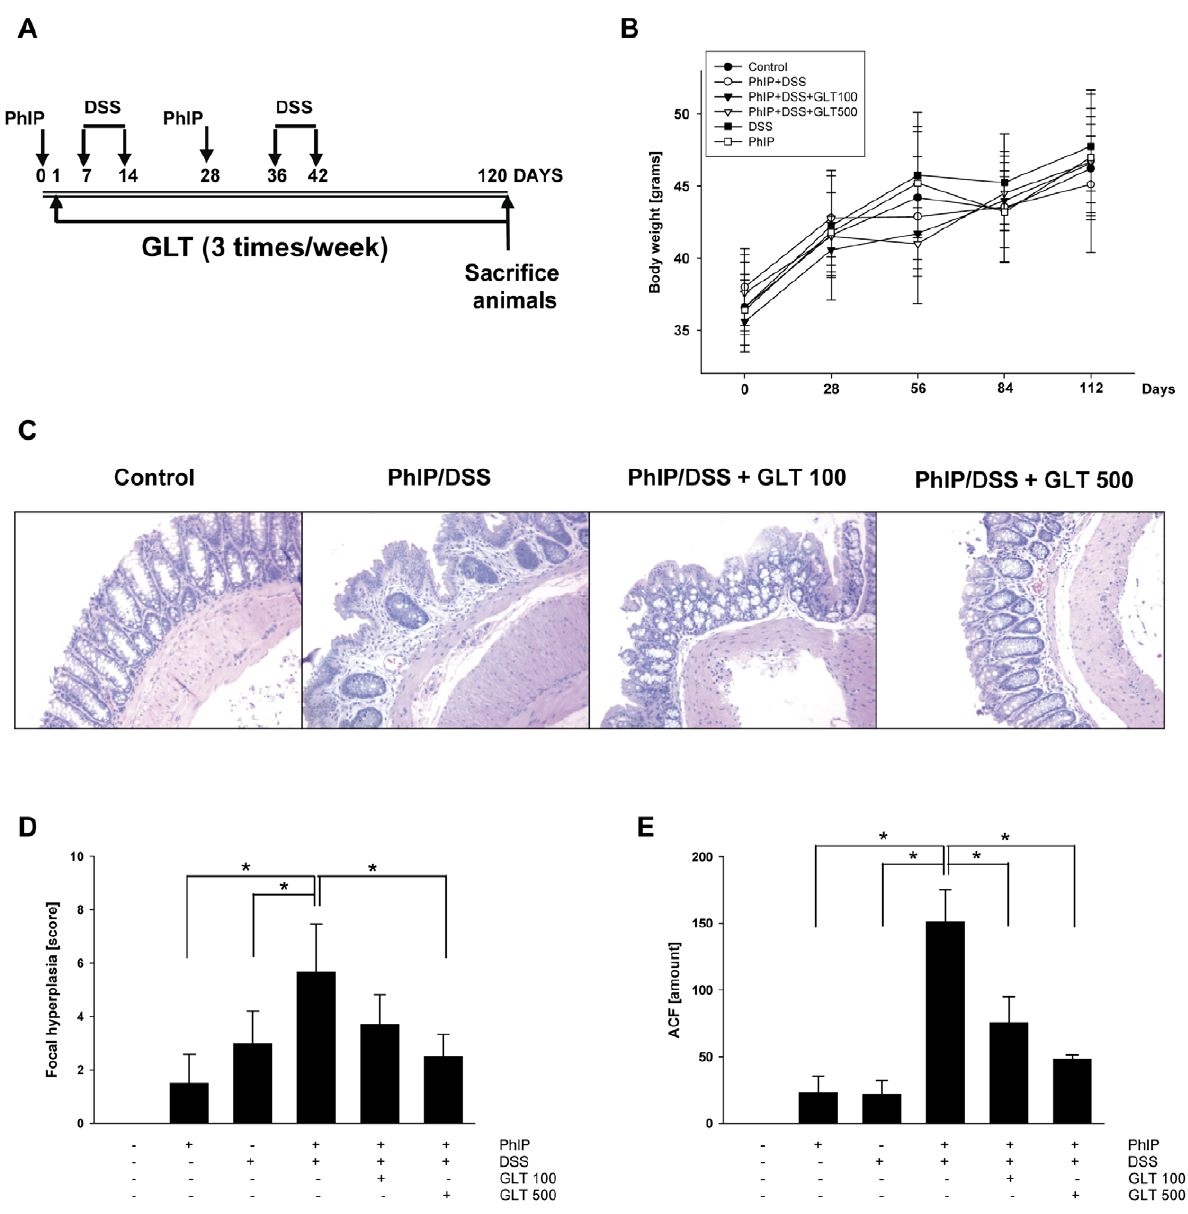
Figure 1. GLT suppresses PhIP/DSS induced formation of colon tumors and inhibits focal hyperplasia and ACF formation. (A) Schematic of the animal treatment. The details of the treatment are described in Materials and Methods . (B) Body weight of control animals (black circle), animals treated with PhIP (white square), DSS (black square), PhIP/DSS (white circle), PhIP/DSS + GLT 100 mg/kg of body weight (black triangle), and PhIP/DSS + GLT 500 mg/kg of body weight (white traingle) during the experiment. (C) H&E staining of representative samples from animal experiments described in Figure 1A. (D) Focal hyperplasia was evaluated by the histological analysis after H&E staining in colon tissue samples as described in Materials and Methods . Results are means 6 SD (n=6–9 mice/per group). (E) ACF formation was evaluated after methylene blue staining as described in Materials and Methods . Results are means 6 SD (n=10 foci/3 mice/per group), *p , 0.05 by ANOVA.